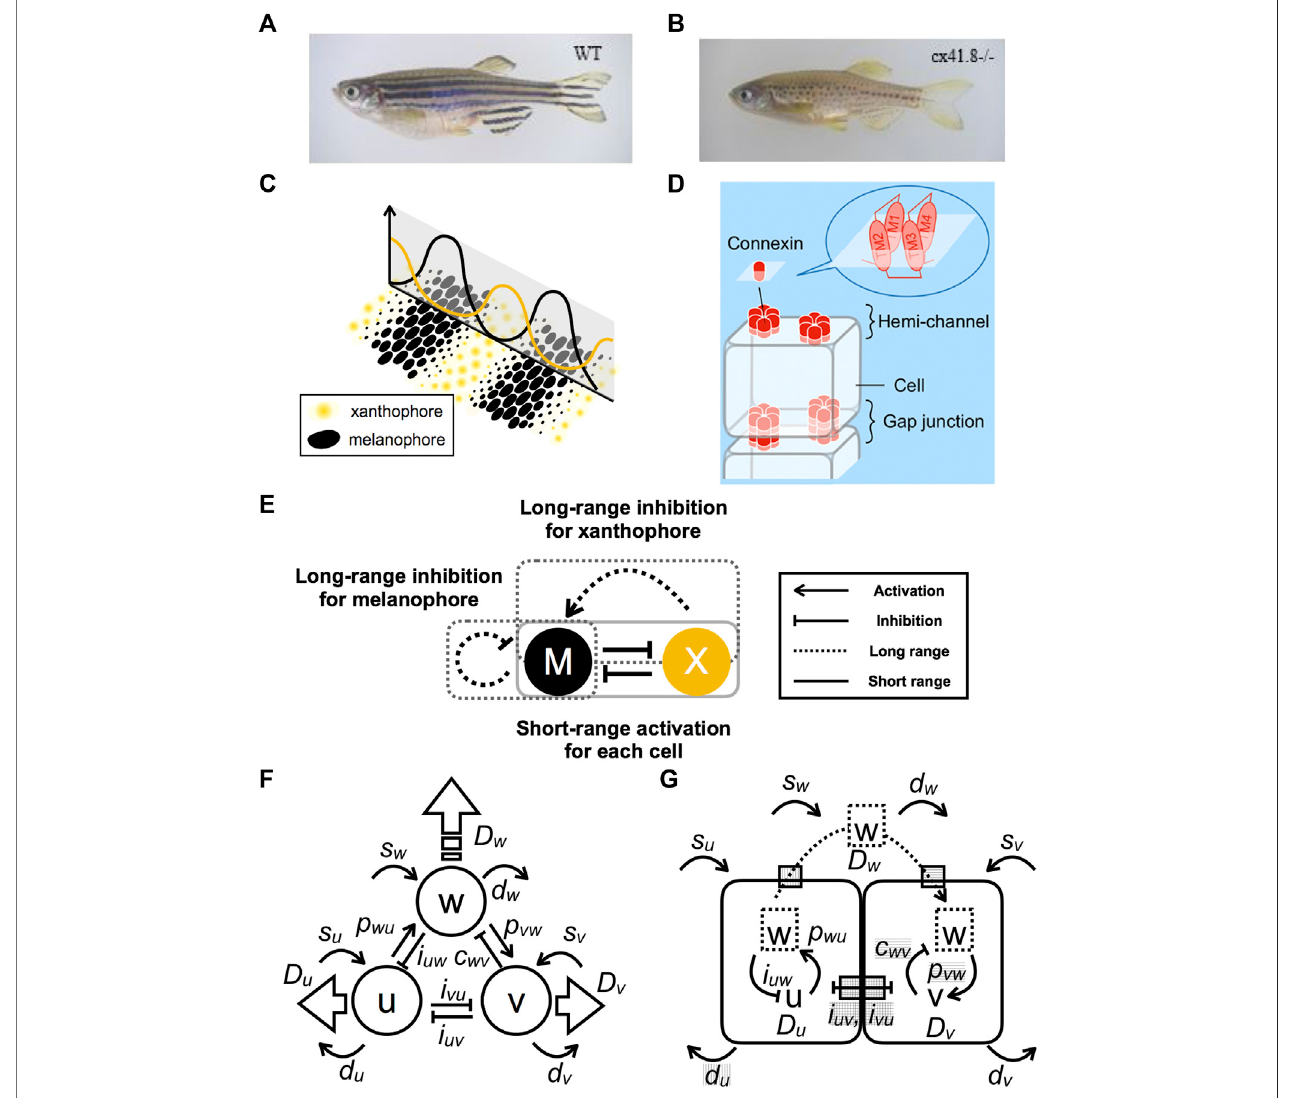
FIGURE 1 | Model-based prediction of defects in channels and interactions. (A) Striped wild-type (WT) zebra fi sh. (B) Spotted leopard mutant zebra fi sh. (C) Schematicrepresentation oftherelationshipbetweenthedistributionofpigment cellsandthenumericalresultofthecontinuous model. (D) Schematicrepresentationof channelscomposedofconnexincomplexes.Hemi-channelsareopentotheoutsideofacell,whereasgapjunctionsformbythedockingofhemi-channelconnectingto adjacent cells. (E) Apparent interactions of pigment cells as revealed by laser ablation experiments. (F) Schematic diagram of a three-component PDE model composed of components U or V , which correspond to melanophores or xanthophores, respectively, and component w , which represents a highly diffusible molecule. Interactions are indicated by fi ne arrows, diffusion coef fi cients (the motility of the components) are indicated by wide arrows, and corresponding parameters are indicated. (G) Schematic diagram of the effect of channels on pigment cells according to the mathematical model. Parameters related to the function of each gate are indicated by